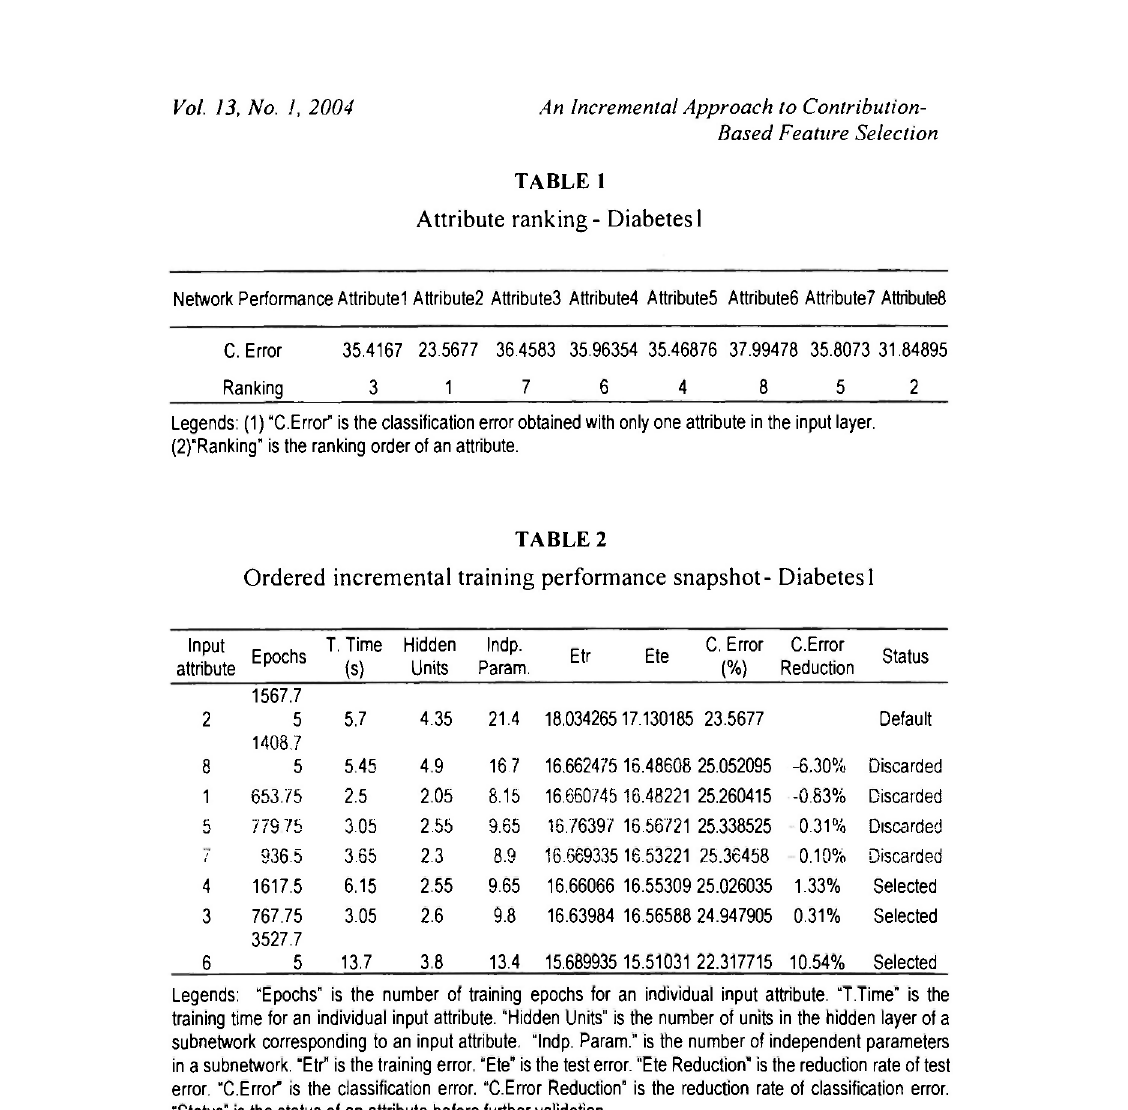
Based Feature Selection